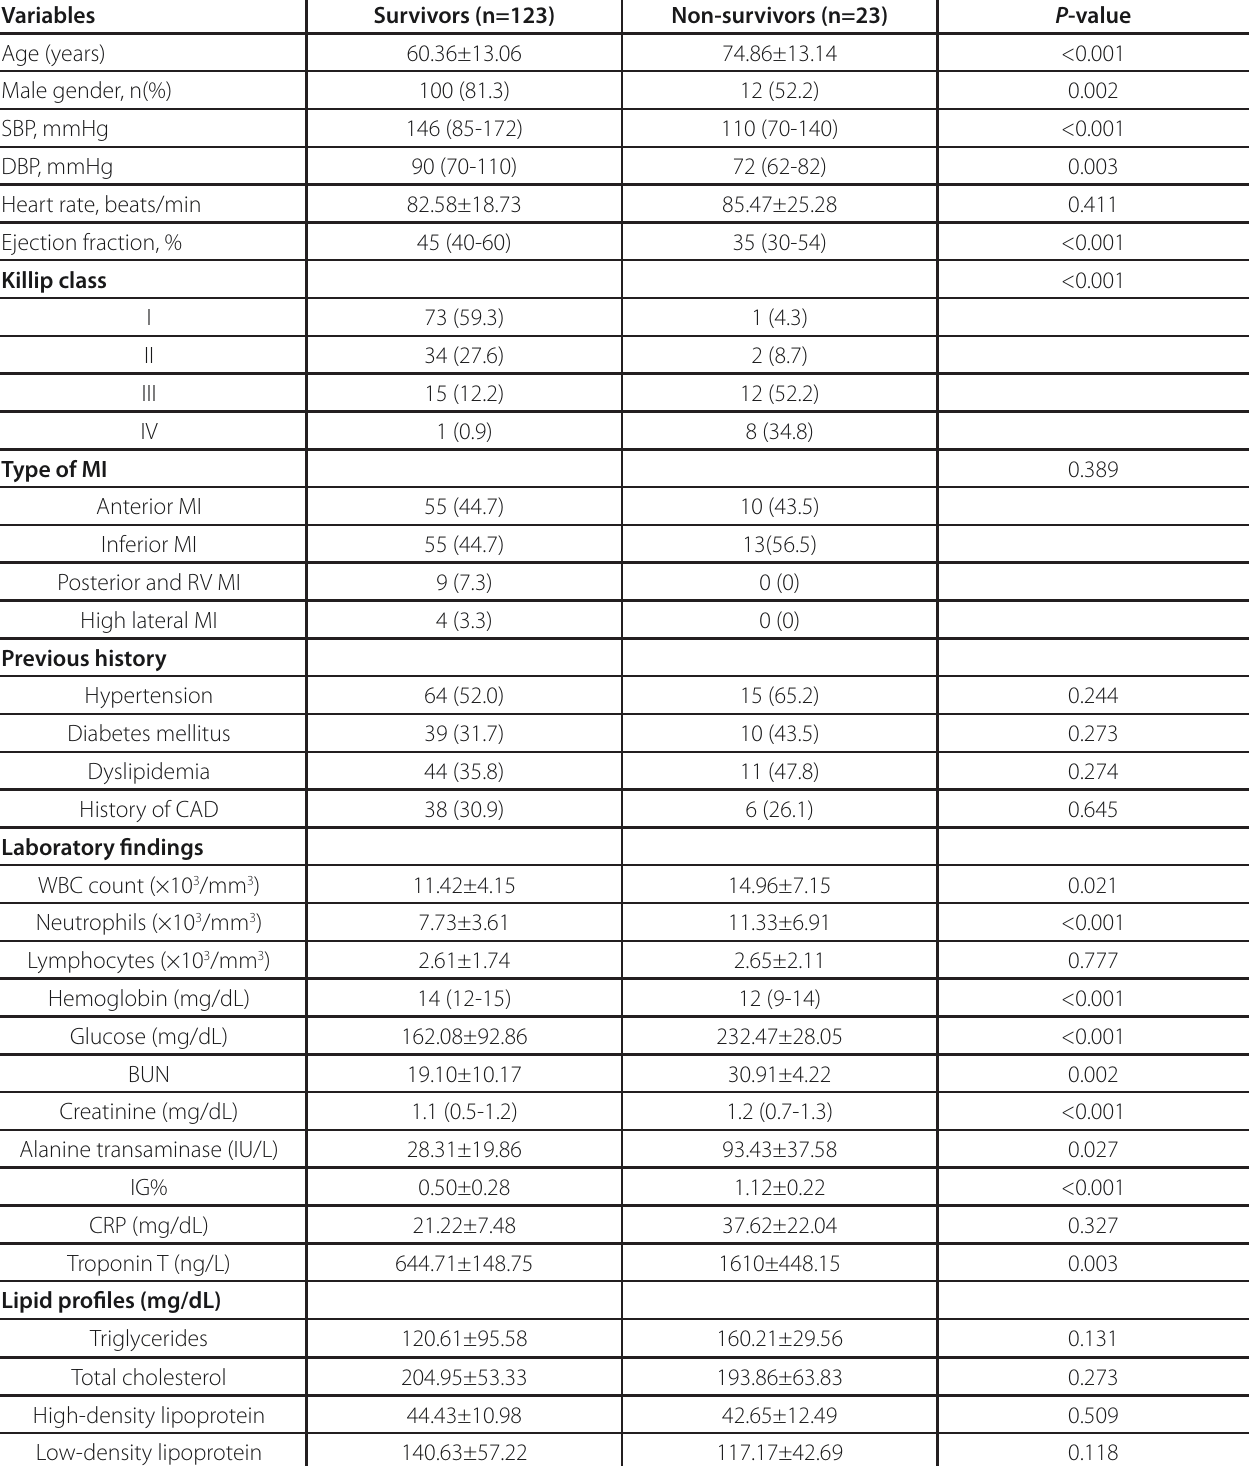
Table 1. Clinical and demographic characteristics of the study population.